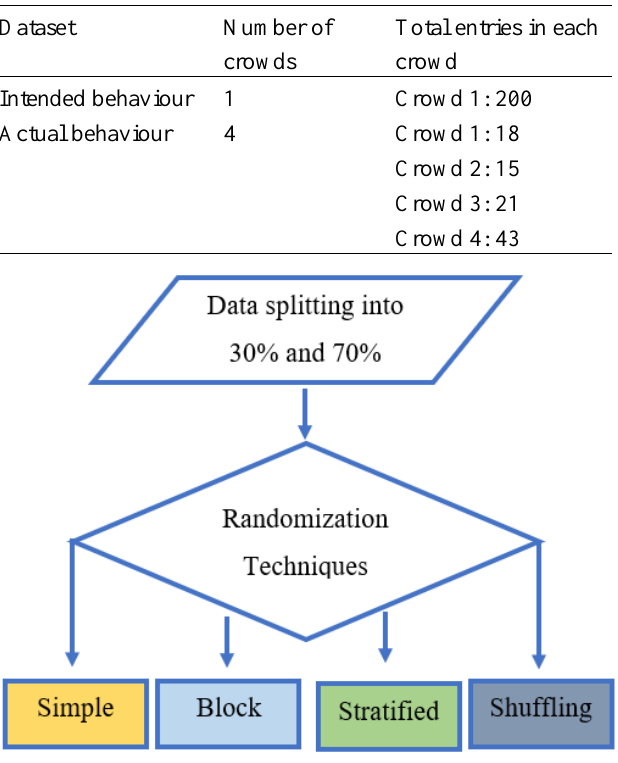
Fig. 2. Randomization techniques on training and testing data Commonly, 70% data with randomization techniques is used for the training of the algorithm and 30% dataset with randomization techniques is used for testing. In this section four machine learning algorithms are applied on the